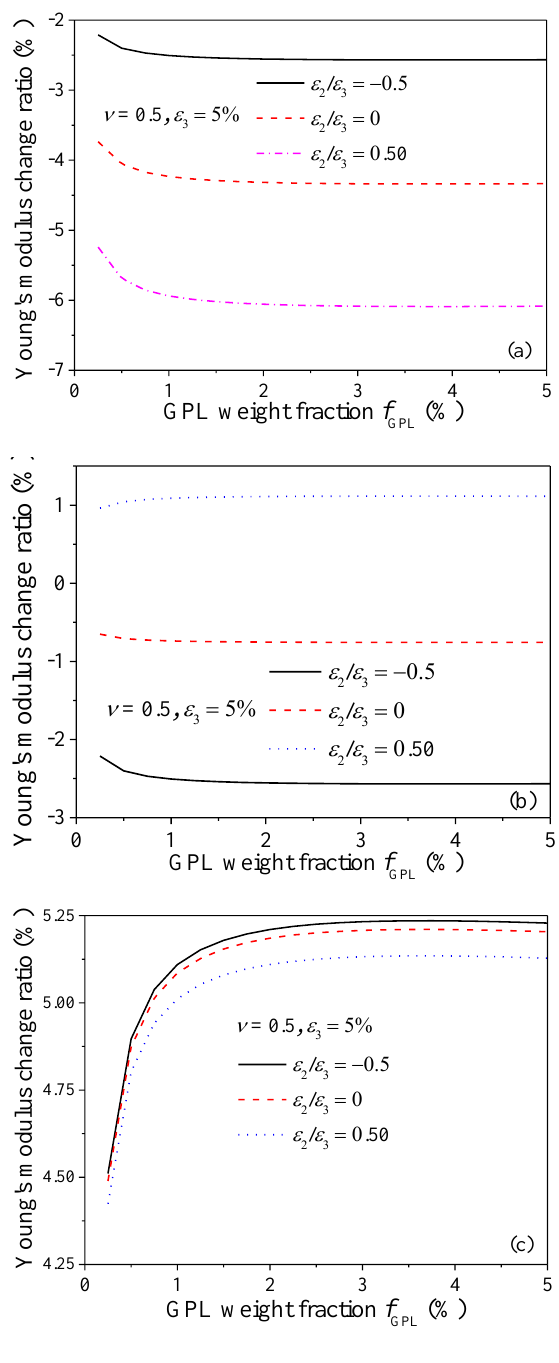
Figure 9. Variation of Young’s modulus change ratio of GPL/epoxy nanocomposites with GPL weight fraction ( a ) X 1 -direction; (b) X 2 -direction; ( c ) X 3 -direction.